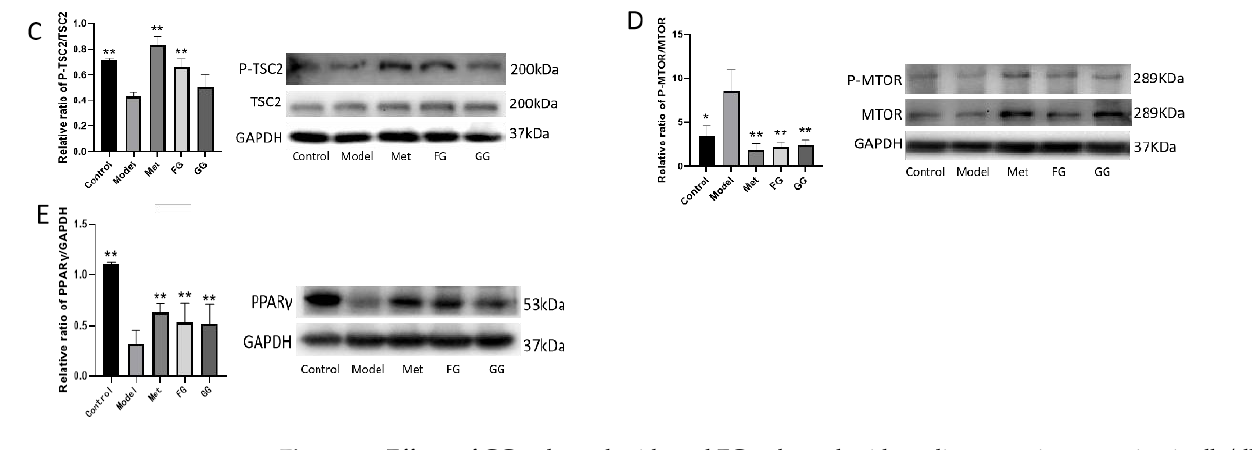
Figure 20. Effects of GG polysaccharide and FG polysaccharide on liver protein expression in